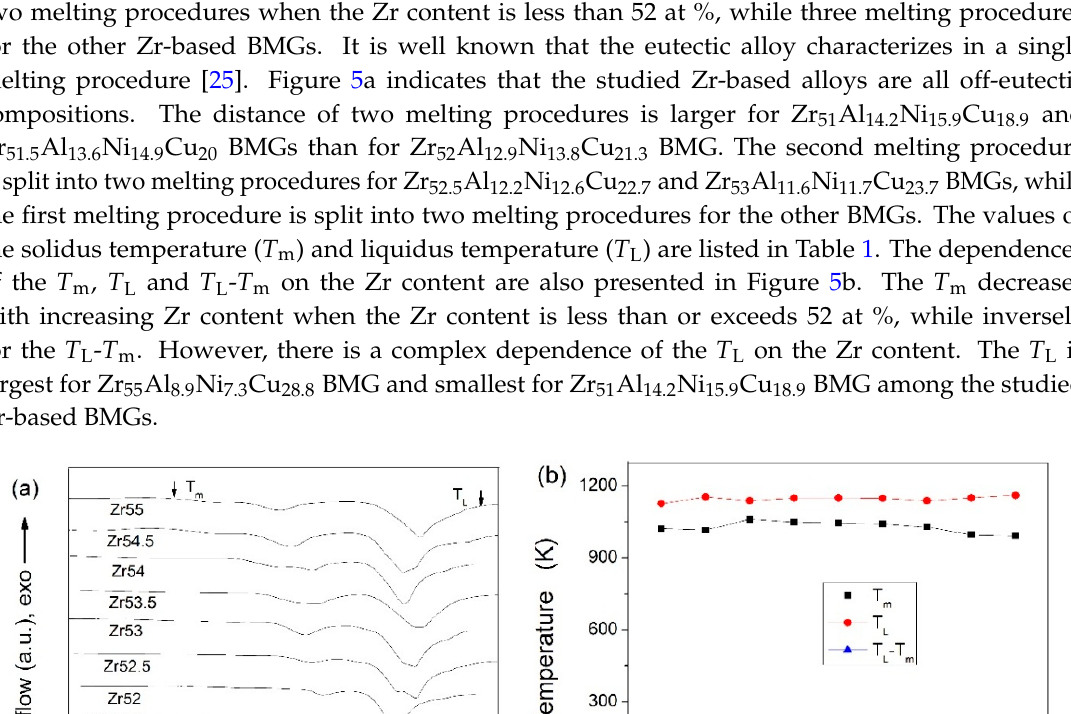
Figure 5. Melting curves at a heating rate of 30 K ∙ min − 1 for the studied Zr-based BMGs ( a ); and dependences of the T m , T L , and T L - T m on the Zr content ( b ). The activation energies of T g , T x , and T p ( E g , E x , and E p ) are calculated by Kissinger equation [26]